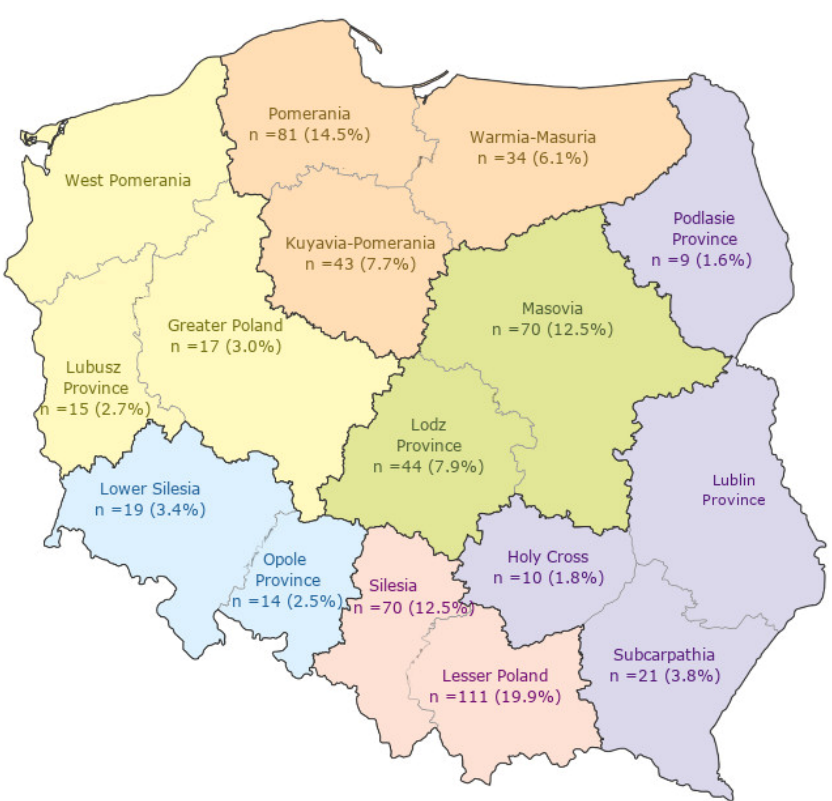
Figure 1. Distribution of the respondents in particular voivodeships.